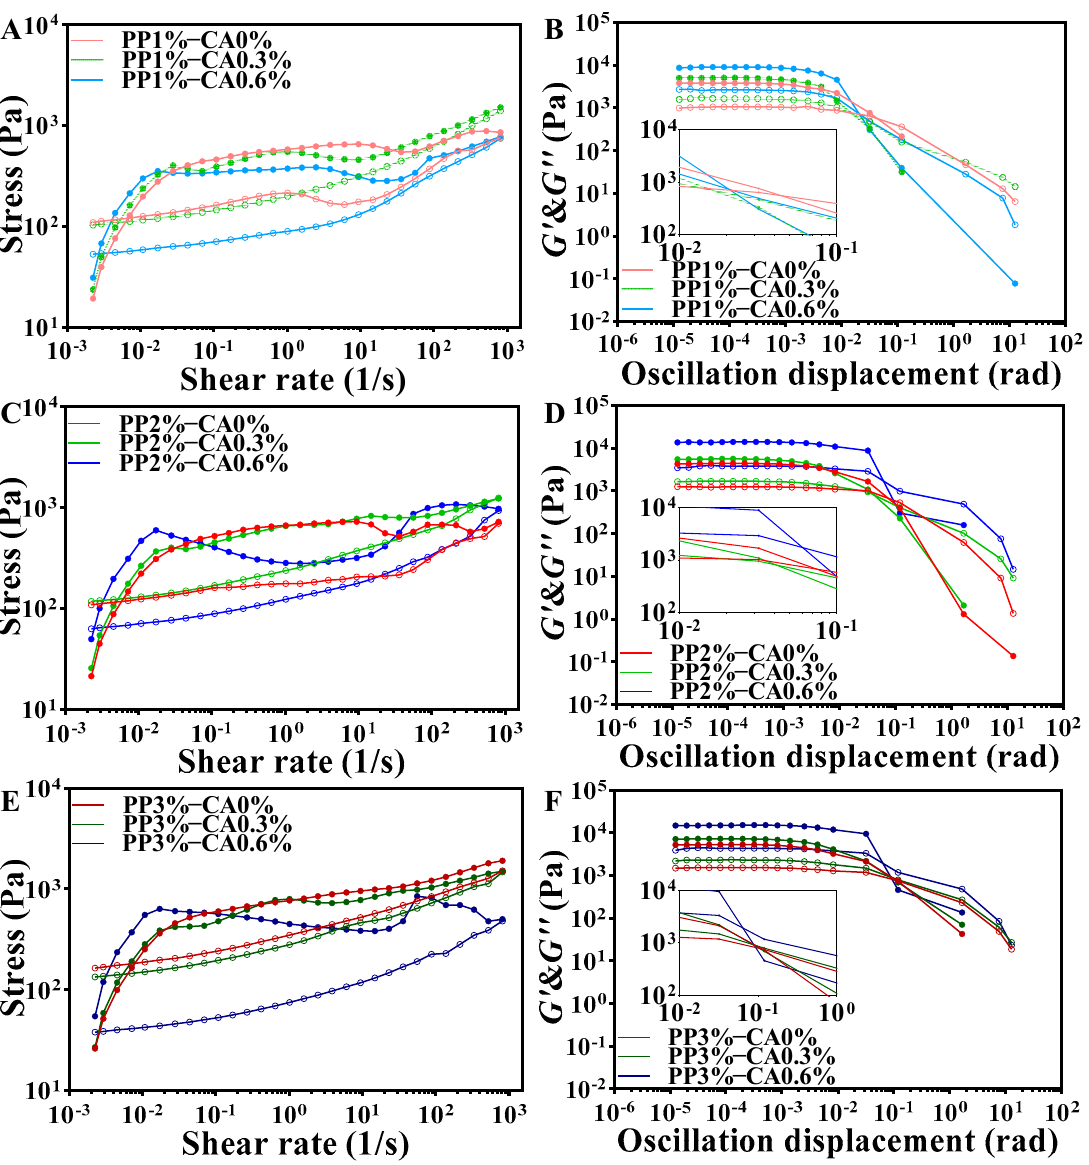
Figure 5. Rheological results of restructured mackerel mince with different PP concentration and CA amounts: The stored modulus ( G (cid:48) ) and the loss modulus ( G (cid:48)(cid:48) ) are represented by solid and hollow icons respectively; ( A , C , E ) are the thixotropic hysteresis loop-stress ramps of restructured mackerel mince; and ( B , D , F ) are the yield stresses of restructured mackerel